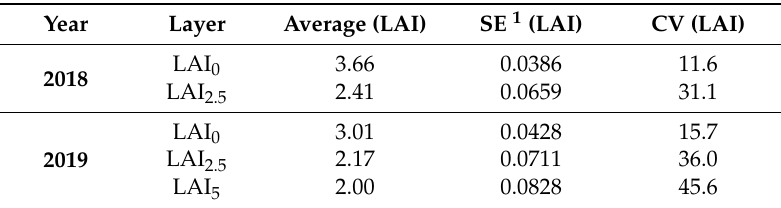
Table 2. LAI summary (n = 121).